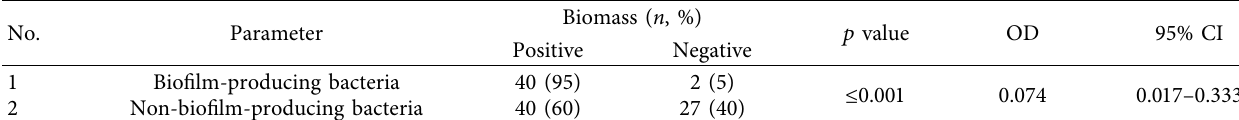
Table 6: Relationship between the biofilm-producing bacteria and the biofilm formation.